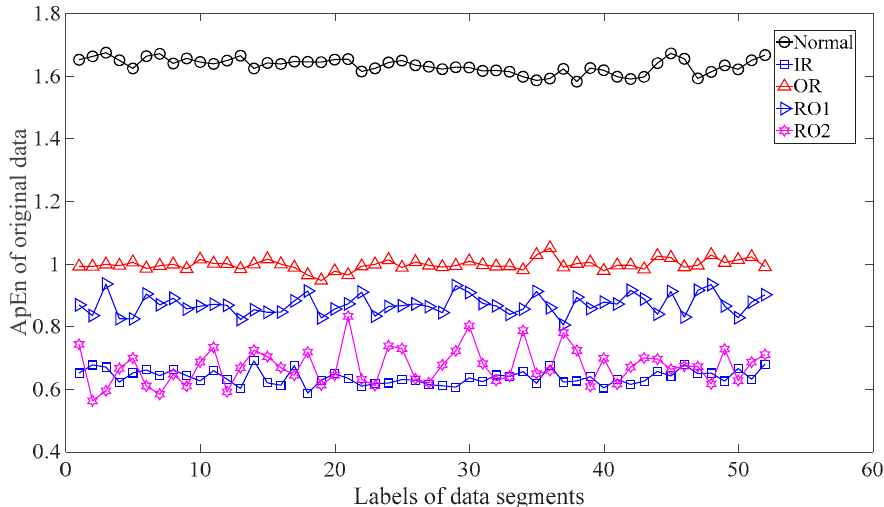
Figure 17. ApEn of the original versions of the five types of roller-bearing vibration data.